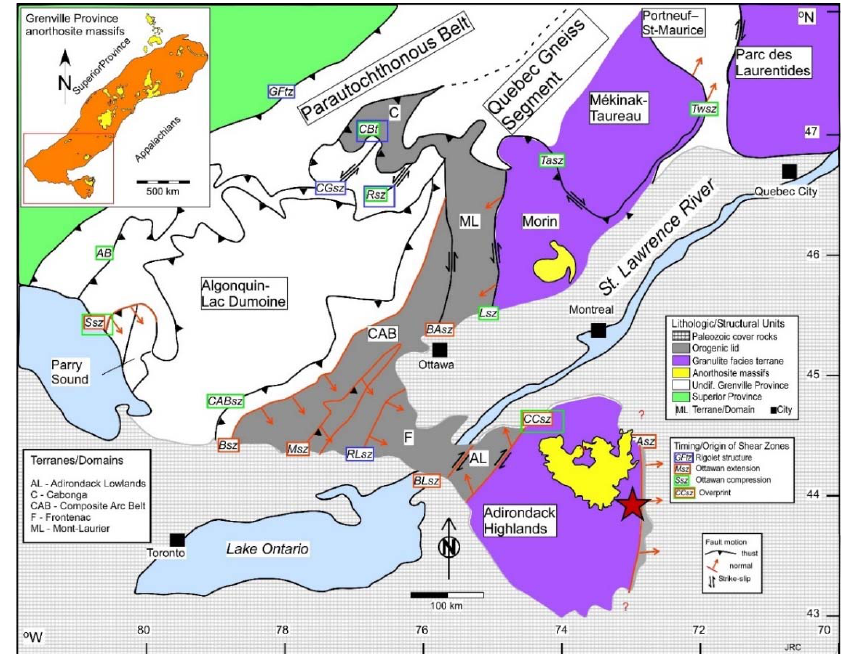
Figure 1. Generalized geologic and tectonic map of the southern Grenville Province (modified from Rivers, T. Can. J. of Earth Sci. 2012 [24]). Black and red lines show major terrain/domain/structural boundaries. Major shear zones are shown by age, tectonic affiliation, and movement history. Shear zones